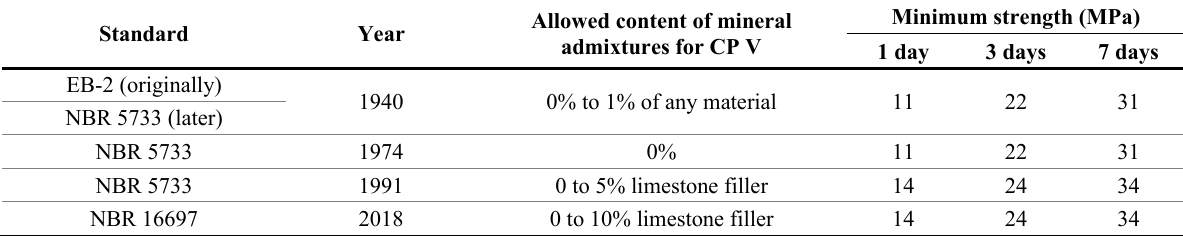
Table 6. Evolution of standardisation of the High Early Strength Portland cement (CP V) in Brazil, in terms of maximum clinker + calcium sulphate replacement in